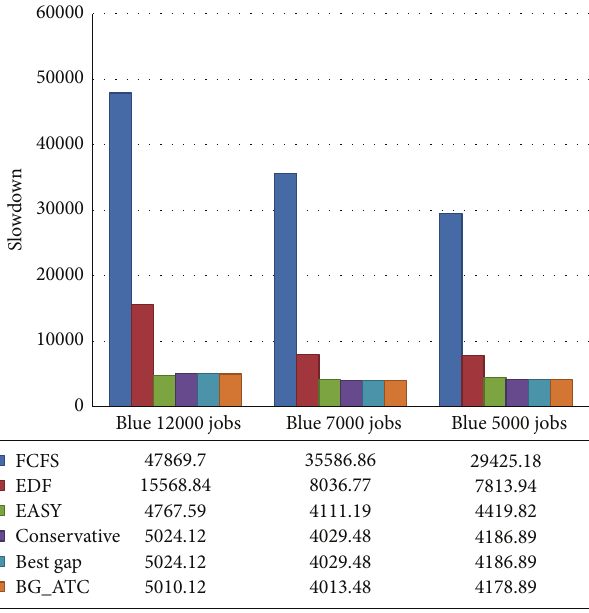
Figure 11: Slowdown comparisons on blue workload.